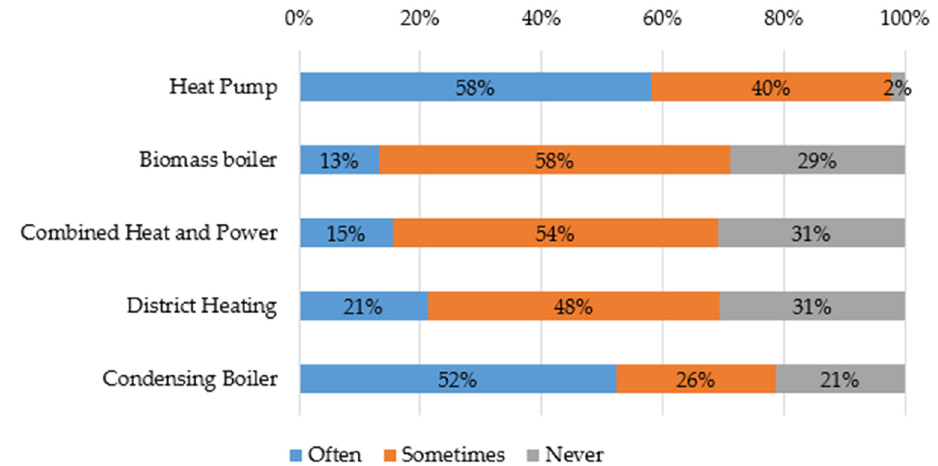
Figure 17. Percentage of active solutions used in nZEBs. Source: survey implemented to building professionals [2].